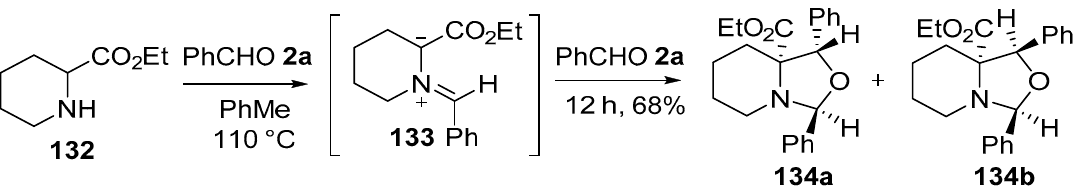
N -benzylglycinate methyl esters and two molar equivalents of formaldehyde or benzaldehyde [110].